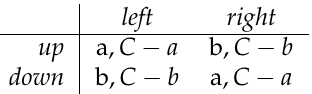
Figure 5. Matching pennies—the only µ – σ zero-sum game with (non-degenerate) mixed